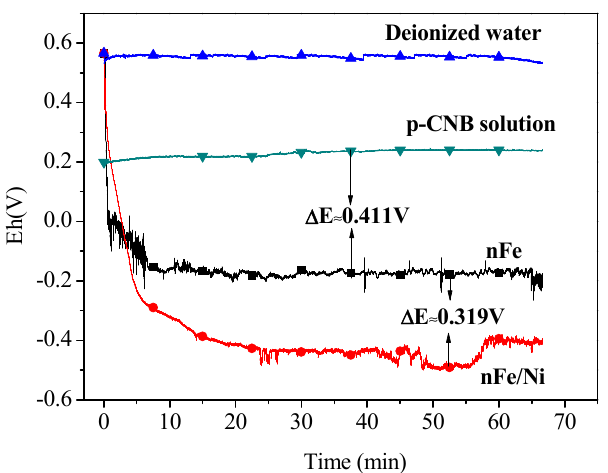
Figure 9. Redox potential of nFe, nFe/Ni and p-CNB solution (concentration of p-CNB = 10 mg/L, dosage of nFe (or nFe/Ni) = 0.5 g/L and initial pH = 5.6 ± 0.1).